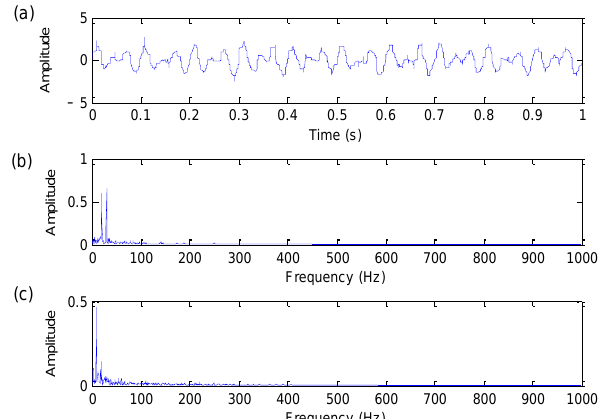
Figure 6. Analysis results obtained by AVG method for simulation signal: ( a ) Time domain waveform; ( b ) amplitude spectrum; ( c ) envelope spectrum.